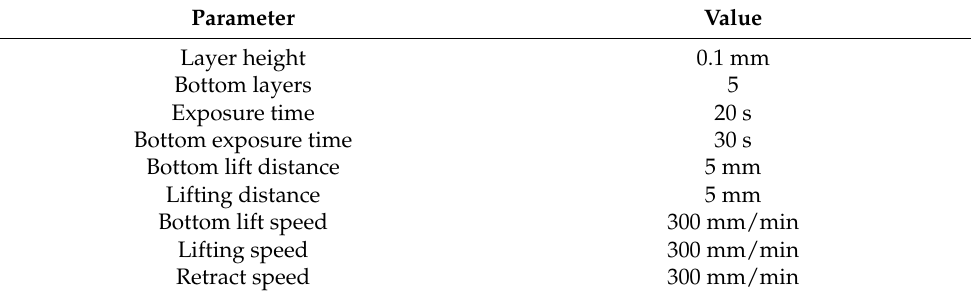
Table 5. Parameters of printing